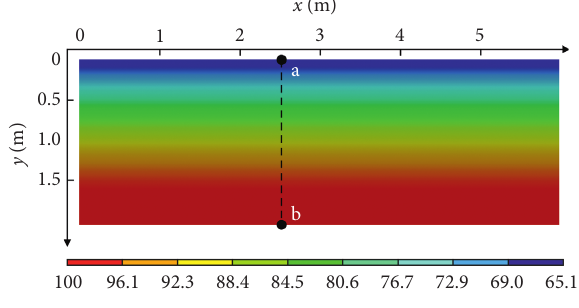
Figure 11: Steady RH contour of foundation.